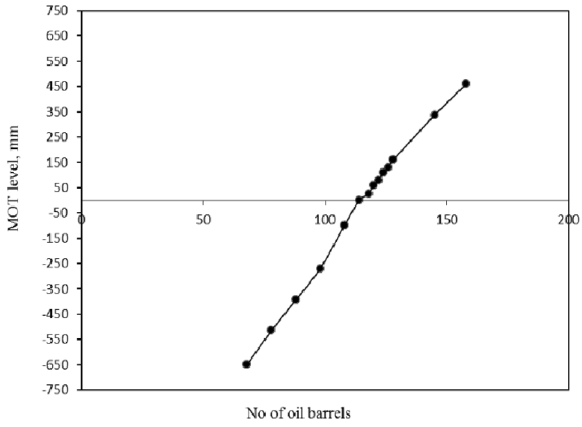
Fig. 4 No. of barrel vs MOT level (MOT level calibration